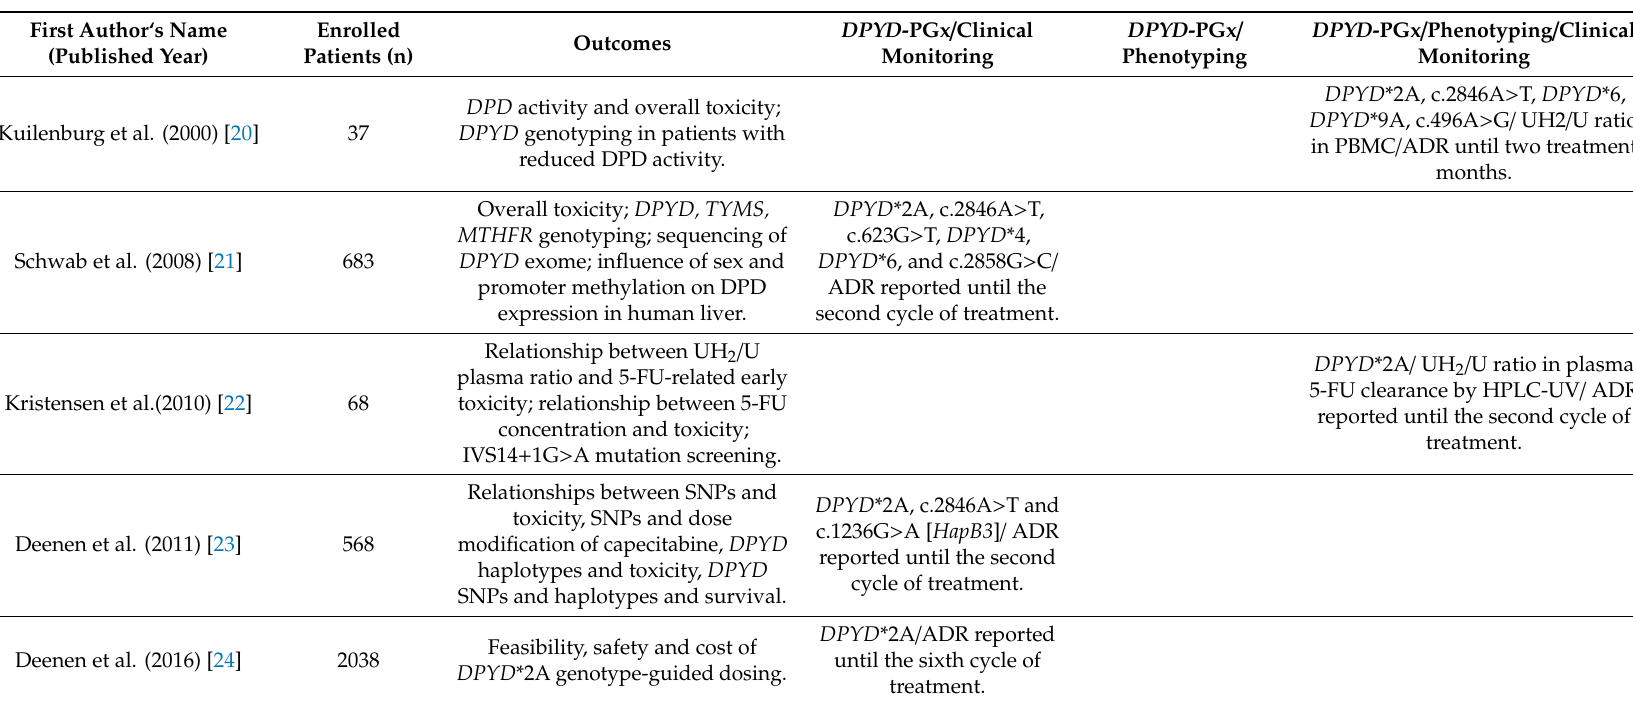
Table 3. The table reports the studies included in the systematic review and subdivided into three groups: DPYD-PGx / clinical monitoring combination, DPYD-PGx / phenotyping and DPYD-PGx / phenotyping / clinical monitoring. Abbreviations: PBMC, peripheral blood mononuclear cells; HPLC-UV, high-performance liquid chromatography-UV detector; LC-MS / MS, liquid chromatography-tandem mass spectrometry; 5-FUDR, 5-FU degradation rate; UHPLC-MS /